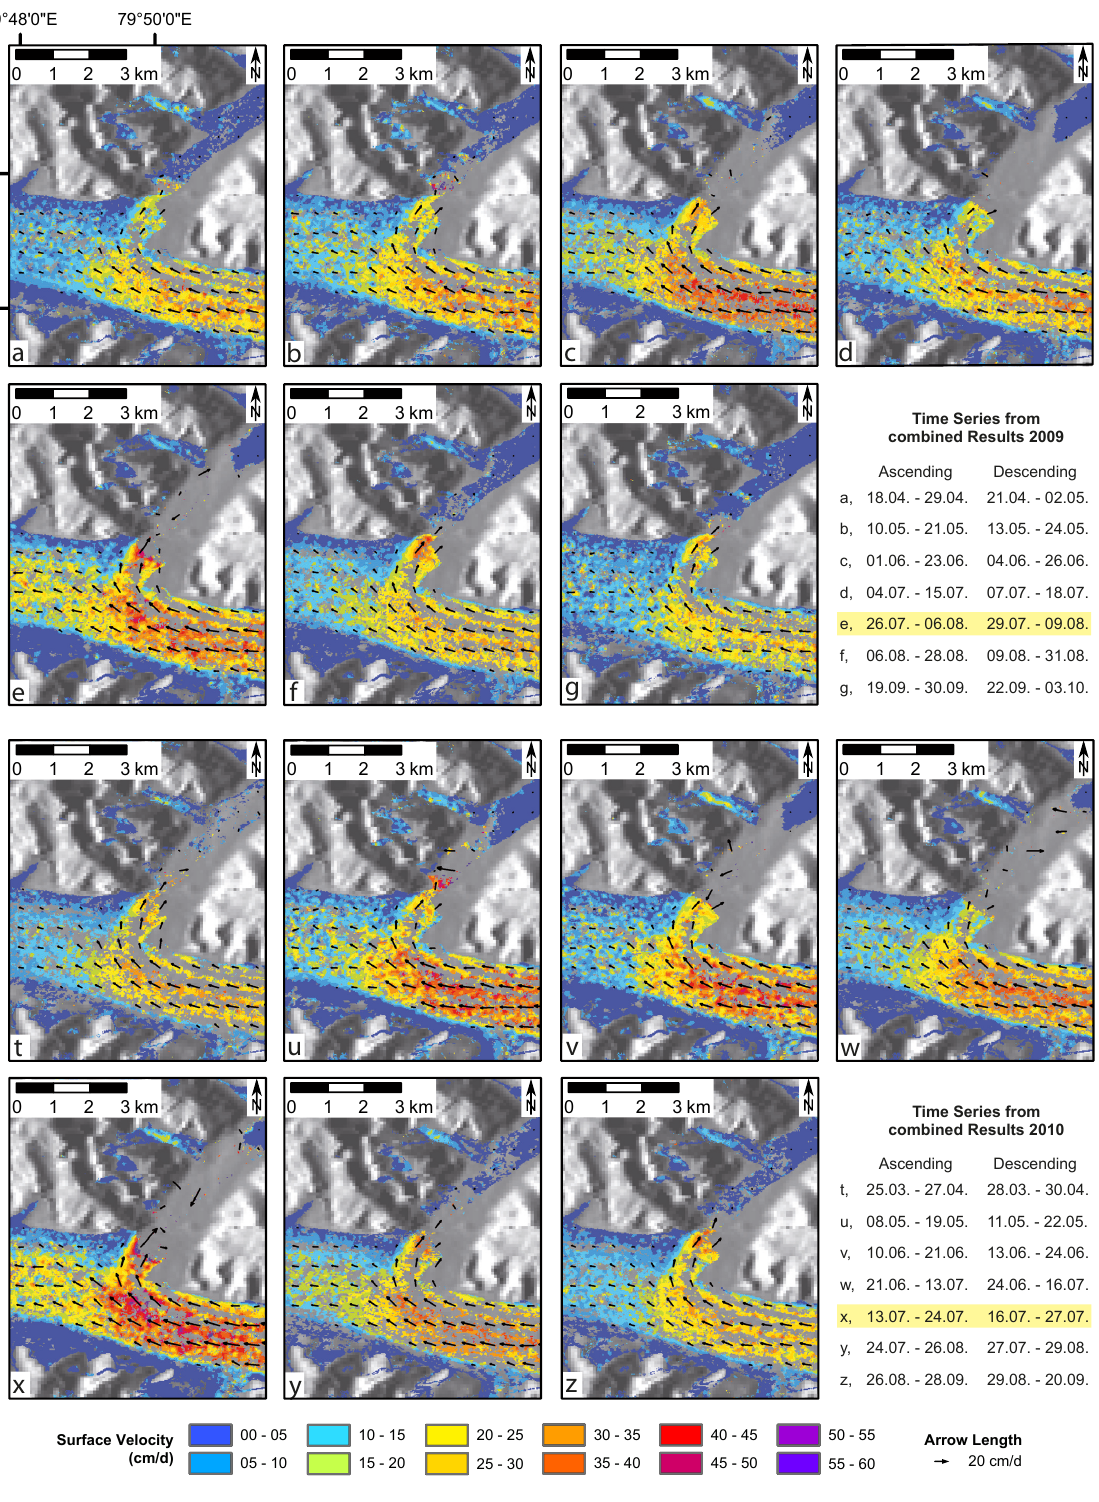
Figure 5. Time series examples for 2009 ( top two rows ) and 2010 ( bottom two rows ) derived from combining ascending and descending results. The yellow highlighting indicates the occurrence of the GLOF